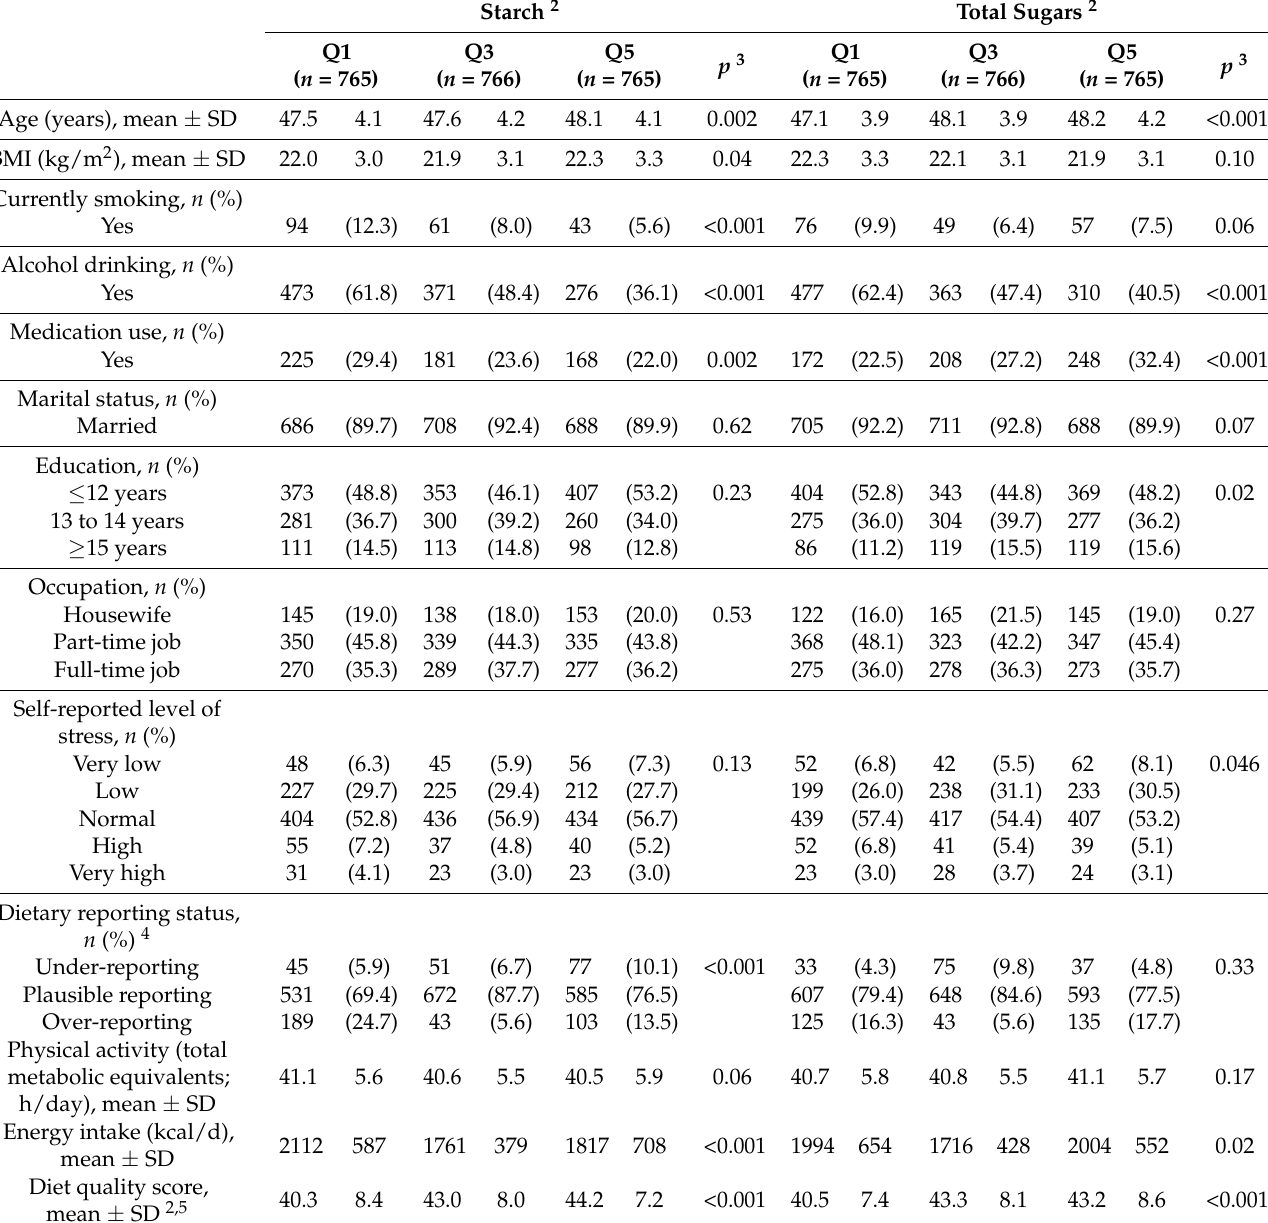
Table 4. Selected characteristics of 3826 middle-aged Japanese women according to the quintiles of the energy-adjusted intakes of starch and total sugars 1